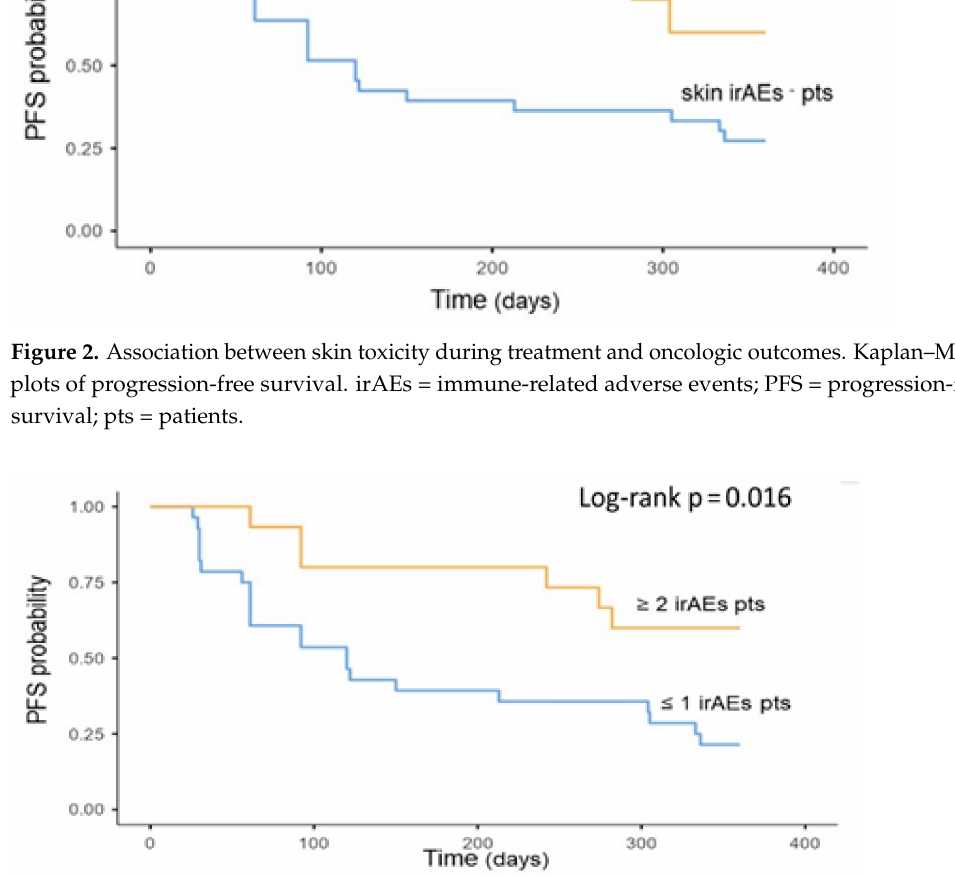
Figure 3. Association between multiple irAEs during treatment and oncologic outcomes. Kaplan– Meier plot of progression-free survival. irAEs = immune-related adverse events; PFS = progression- free survival; Pts =